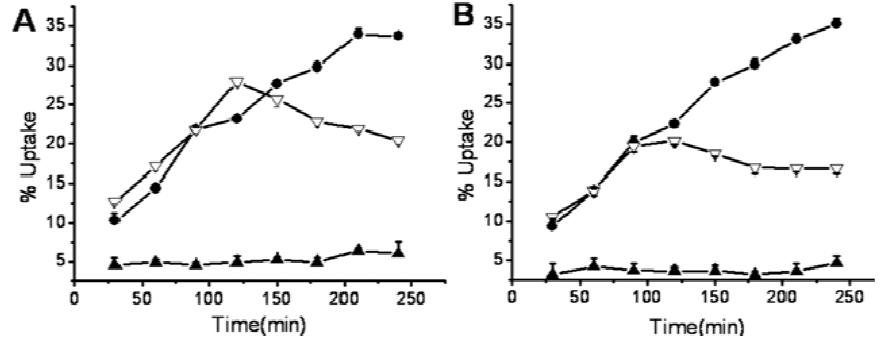
Figure 3. The accumulation of 99m Tc -1 ( A ) and 99m Tc -2 ( B ) in S180 cells under anoxic conditions (black dot), normoxic conditions (black triangle) and anoxic switched to normoxic after 2 h (blank